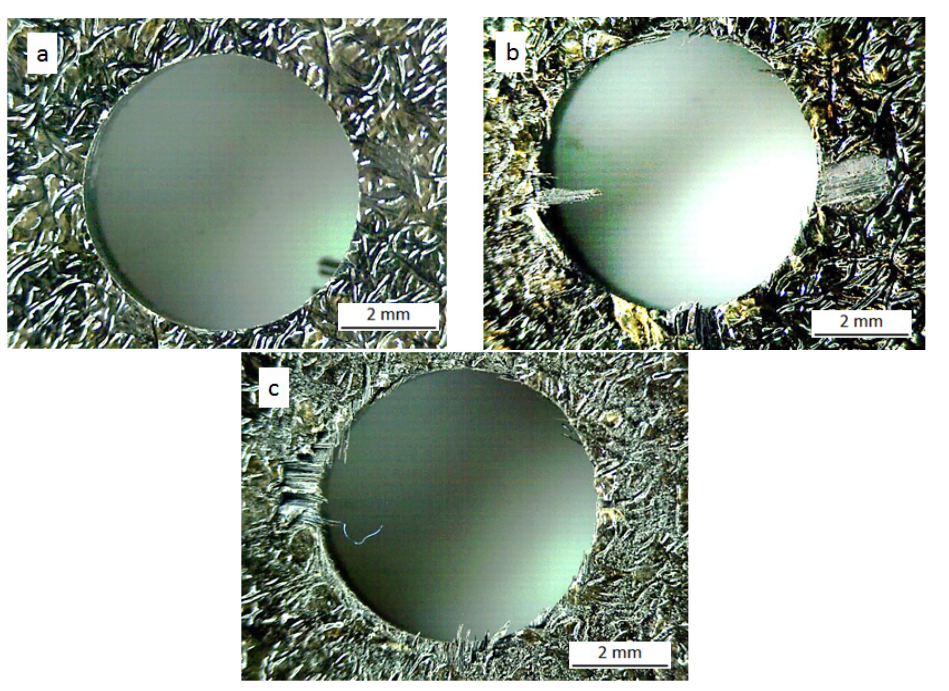
Figure 6. Push out delamination at the hole exit for new tool ( a ), flank wear tool ( b ) and honed edge tool ( c ) with point angle 118°, V = 50 m/min and f = 0.05 mm/rev.